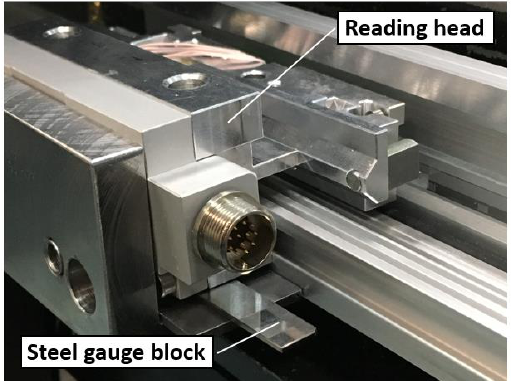
Figure 4. The reading head of the linear encoder mounted on the linear comparator with the yaw inaccuracy achieved by a steel gauge block. inaccuracy achieved by a steel gauge